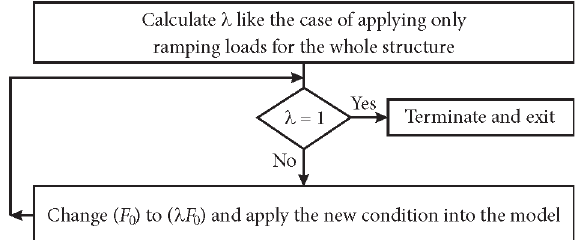
Fig. 2. The algorithm applied for considering the weight of the structure as a constant load (Hasanzadehshooiili et al. 2012b)